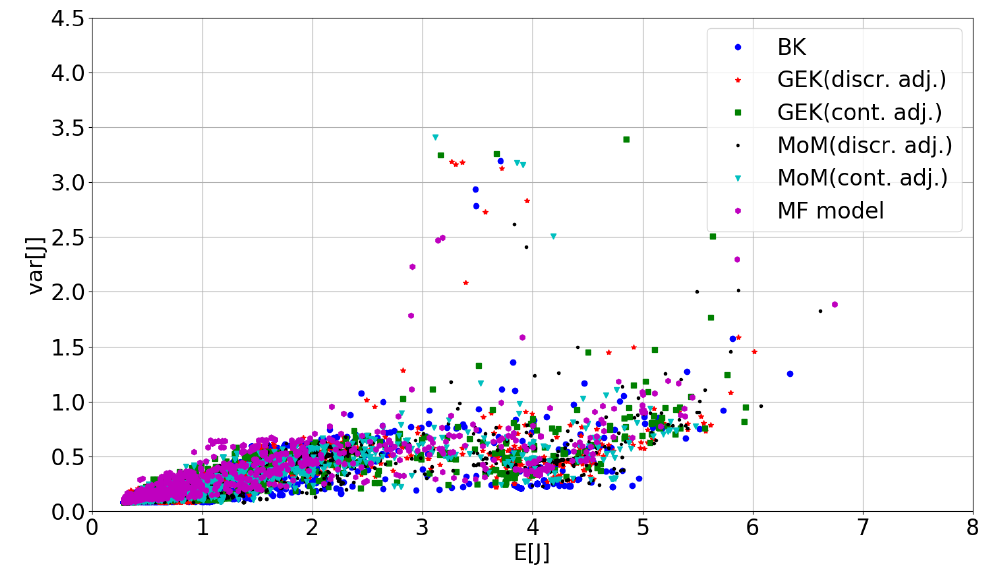
Figure 5. Objective